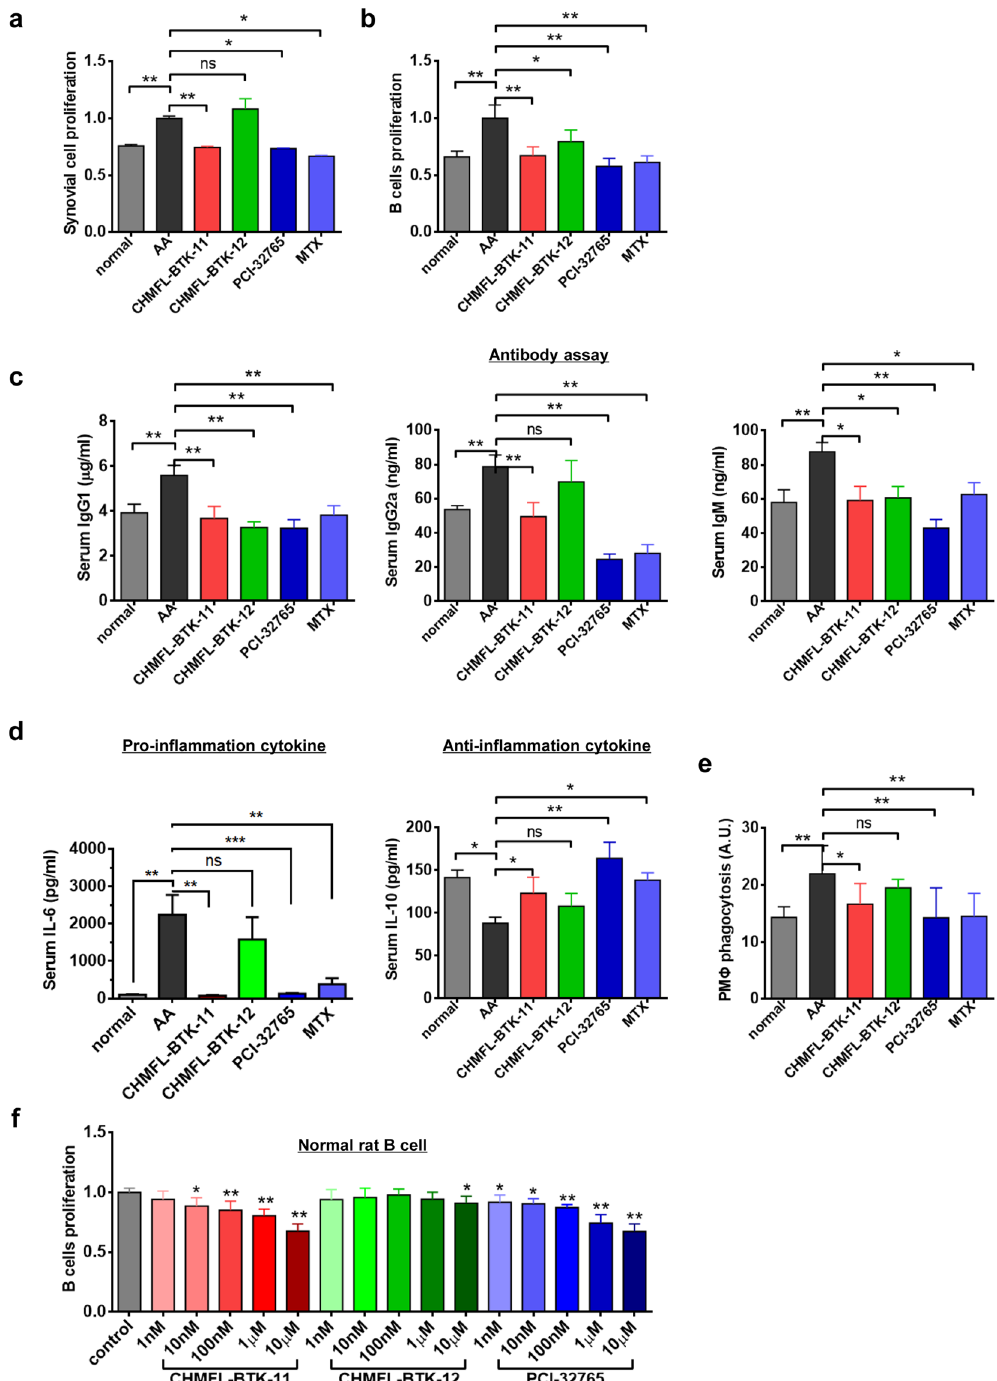
Figure 4. CHMFL-BTK-11 inhibits synovial cells and B cells proliferation and ameliorates total serum antibody production in AA rat model. ( a ) CHMFL-BTK-11 inhibits the synovial cells proliferation from AA rats. ( b ) CHMFL-BTK-11 inhibits B cells proliferation induced by LPS from AA rats. ( c ) Antibodies assay (IgG1, IgG2a, and IgM) from AA rats after drug administration. ( d ) Serum IL-6 and IL-10 measurement from AA rats after drug administration. ( e ) CHMFL-BTK-11 reduced the peritoneal macrophages (PM Φ ) phagocytosis from AA rats. ( f ) The inhibitory effects of CHMFL-BTK-11 on proliferation of rat B cells. CHMFL-BTK-12, PCI-32765, or MTX were set as controls. Student’s t-test was used and data were representative of at least 2 independent experiments. ns, P > 0.05, * P < 0.05, ** P <